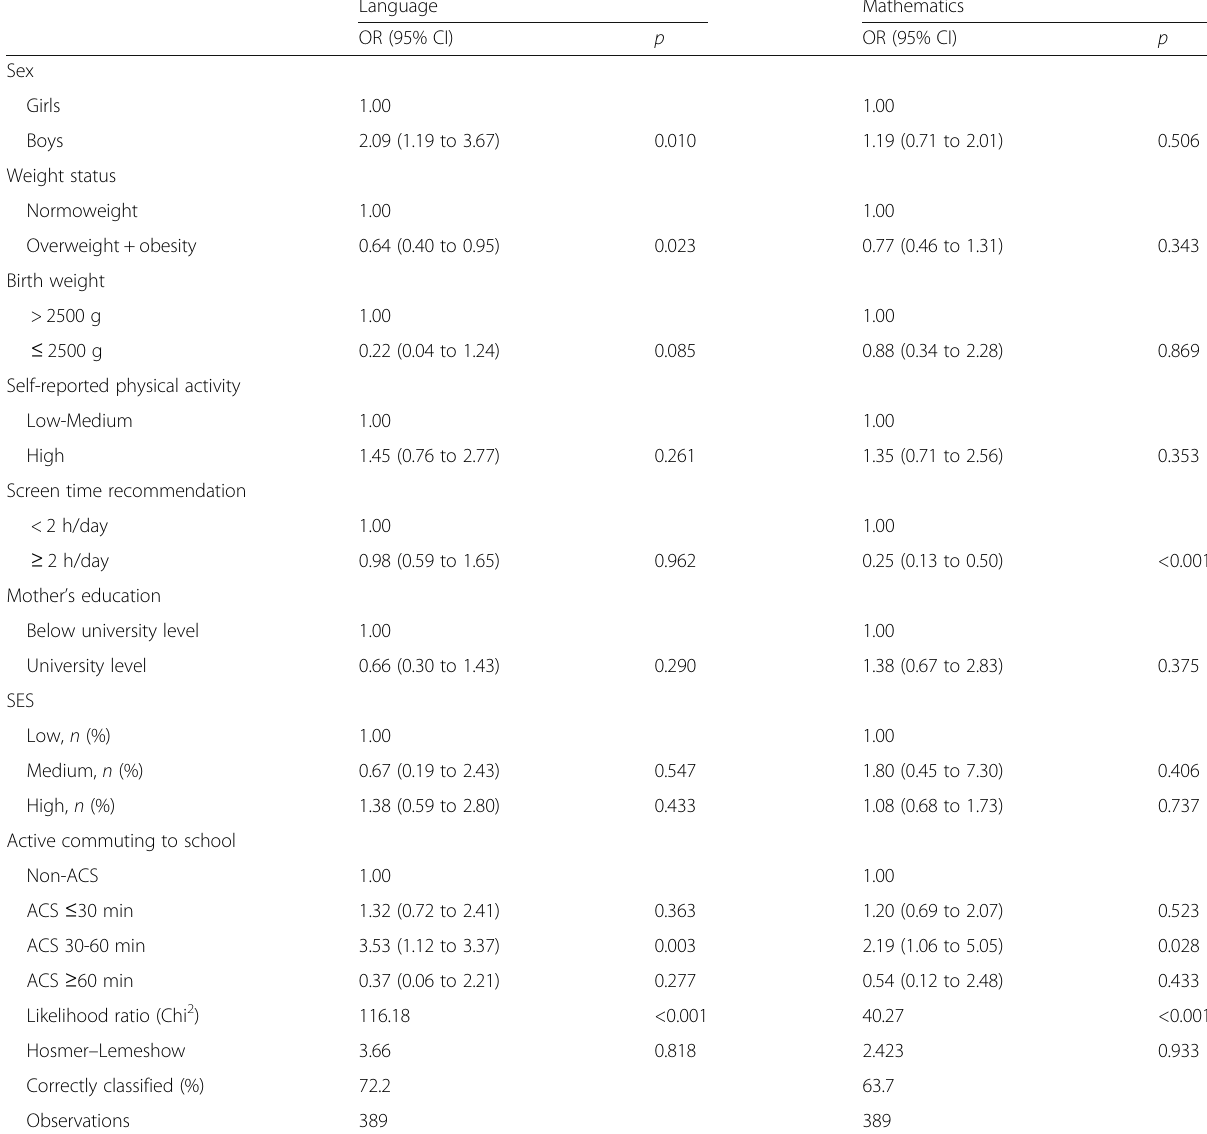
Table 2 Logistic regression analyses for duration of walking ACS associated with academic achievement in Chilean adolescents, after adjusting for sex, weight status, birth weight, physical activity, screen time, maternal education, and